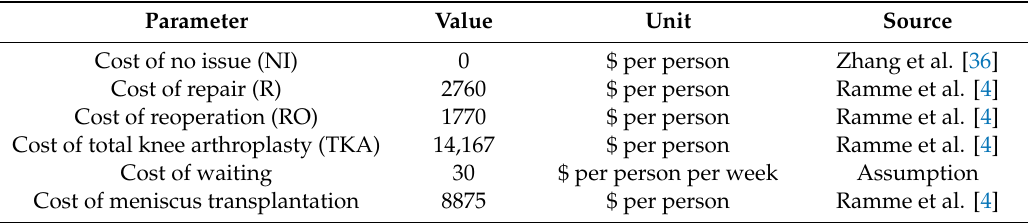
Table 1. List of parameters in the simulation of traditional meniscus transplantation.